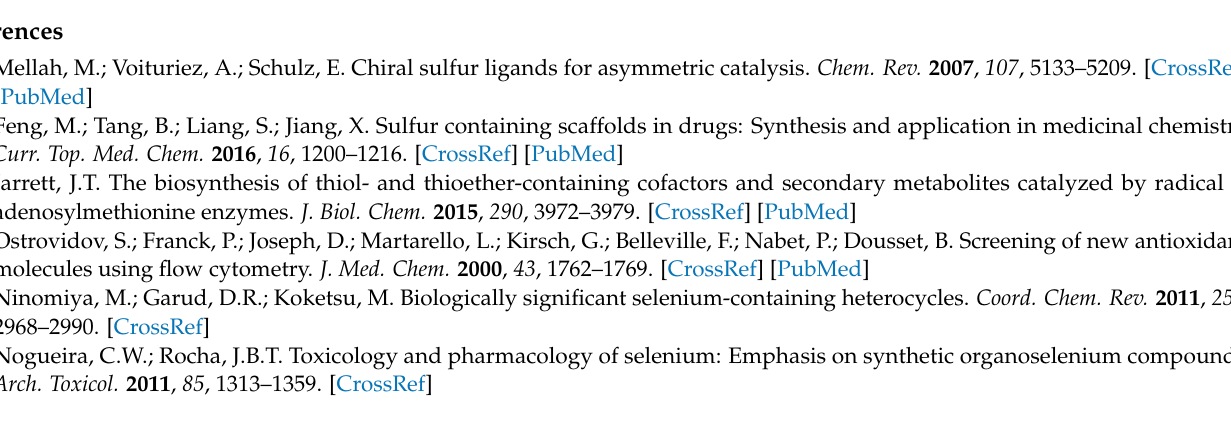
(B) SEM image of GO, Figure S2: TEM image of graphite, Figure S3: TEM image of GO, Figure S4: AFM image of GO, Figure S5: Raman image of GO I D /I G ratio = 0.87, Figure S6: XRD image of